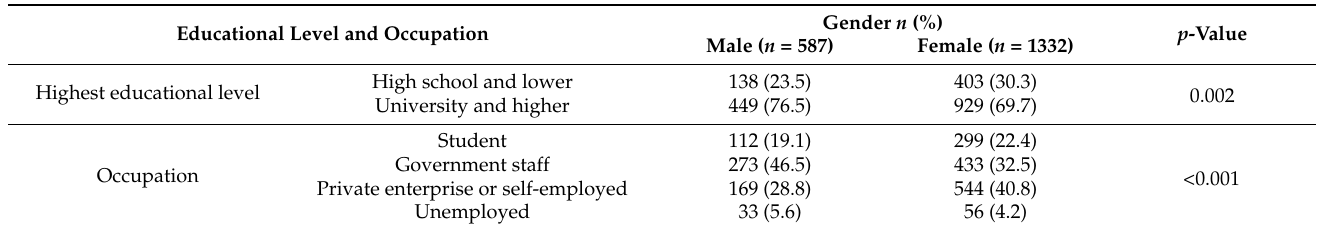
Table 3. Distribution of the educational level/occupation of the participants by gender ( n = 1919).